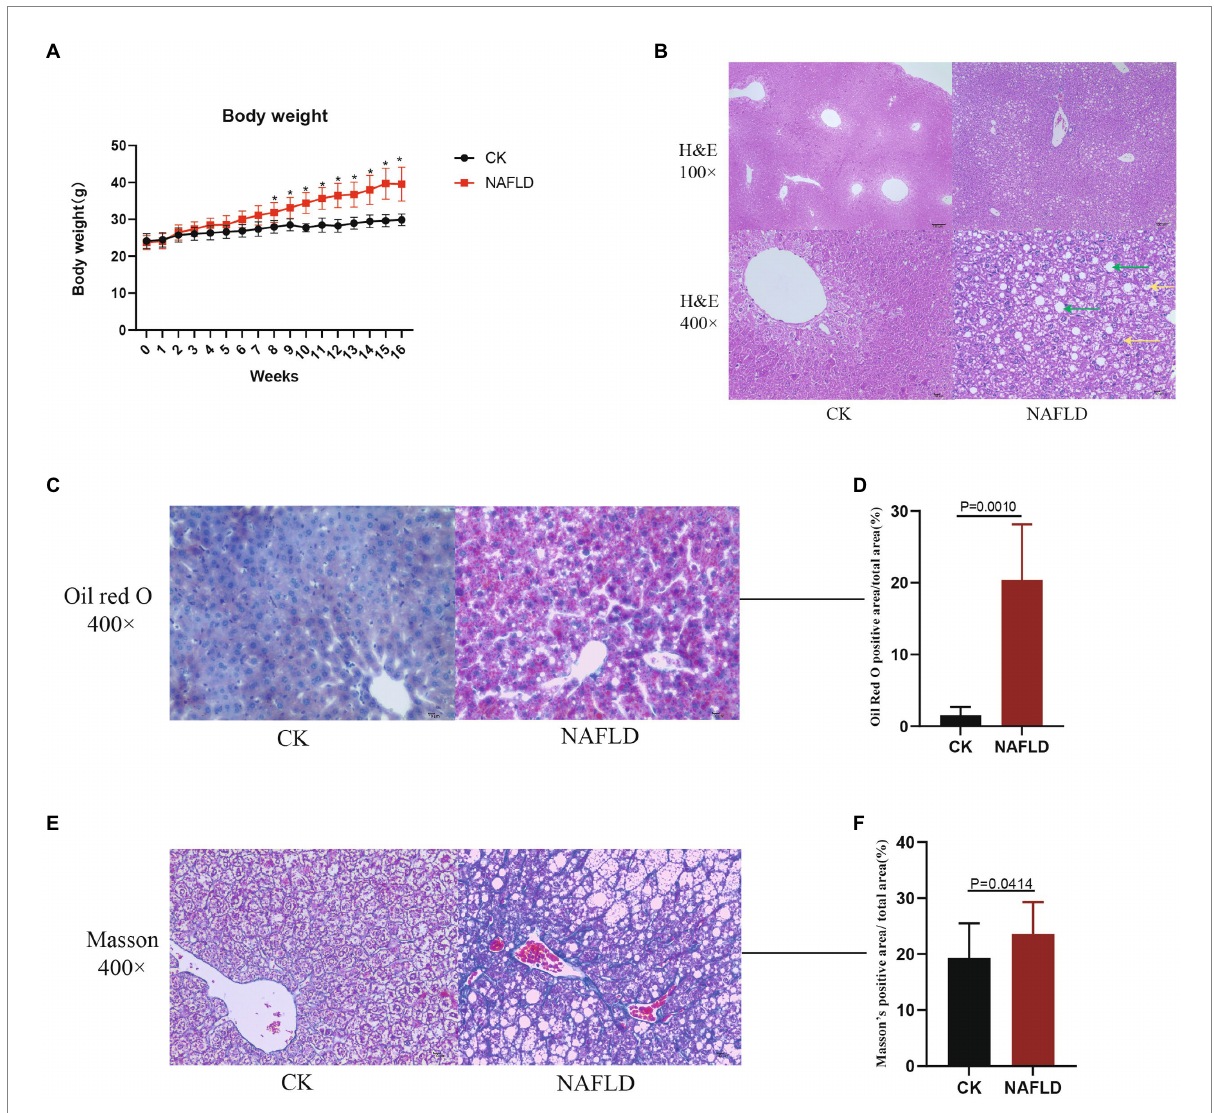
FIGURE 1 The body weight and Histopathology with Control and NAFLD mice. (A) Body weight changes in ND or HFD fed mice over 16 weeks. (B) Representative pictures of hematoxylin and eosin (H&E) staining for liver (100× and 400×), the green arrows indicate hepatic cell steatosis, and the yellow arrows indicate hepatic cell balloon-like changes. (C,D) Representative pictures of Oil red O staining for liver (400×) and quantitative analysis of lipid droplets relative amount. (E,F) Representative pictures of Masson staining for liver (400×) and quantitative analysis of the relative amount of collagen. Significance was assessed by Student t-test